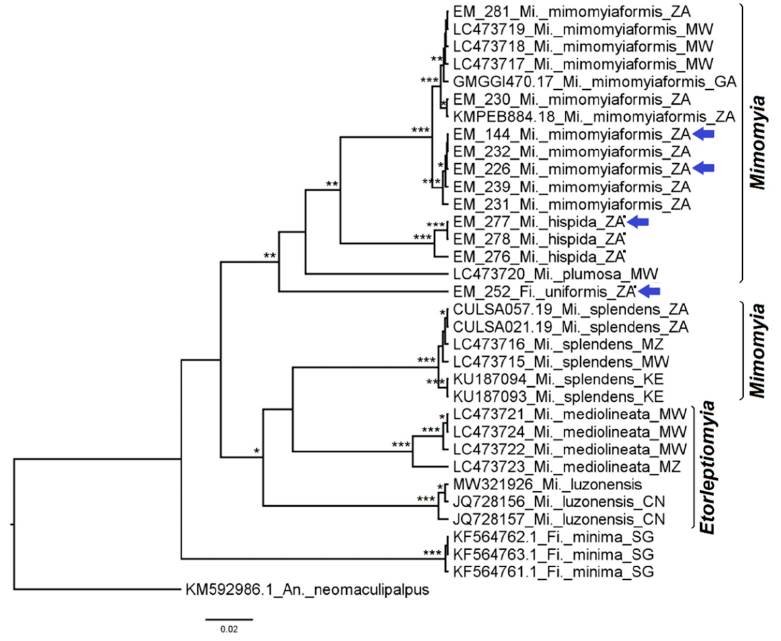
Figure 15 . Phylogenetic analysis of 33 partial coxI nucleotide sequences from mosquitoes of the Ficalbia and Mimomyia genera. At specific branches, the number of * indicates the tree topological support revealed by the different phylogenetic reconstruction methods, assuming relevant bootstrap and aLRT values above 75% and posterior probability values above 0.80. The sequences obtained in this work are indicated by the “EM” code and those with associated genitalia are indicated by horizontal blue arrows. The sequences downloaded from GenBank and Boldsystems are indicated by their respective accession numbers and access codes (respectively); the symbol “.” after the code of our sequence indicates that said sequence was not identified by Boldsystems. Their country of origin [South Africa (ZA), China (CN), Gabon (GA), Malawi (MW), Mozambique (MZ), Kenya (KE)] are also indicated. The vertical lines mark the subgenera of Mimomyia and Etorleptiomyia. 3.2.6. Genus Coquillettidia Sequences from the South African Cq. ( Coquillettidia ) chrysosoma (Edwards, 1915) specimens (File S-II Figure S51) grouped with Cq. ( Coq. ) fuscopennata (Theobald, 1903), Cq. ( Coq. ) aurites (Theobald, 1901), and Cq. chrysosoma sequences from Kenya, with an intra- clade variation of 0.2% ± 0.1 (Figure 16). Sequences of Cq. fuscopennata from South Africa (File S-II Figure S49) clustered with a sequence from Malawi in a monophyletic clade with an intraspecific variation of 0.5% ± 0.2, while another clade clustered GenBank sequences from Cq. fuscopennata , Cq. (Coq.) versicolor (Edwards, 1913) and Cq. (Coq.) microannulata (Theobald, 1911). The sequence of Cq . ( Coq. ) metallica (Theobald, 1901) from Mozambique (File S-II Figure S50) clustered in a monophyletic clade with an intraspecific variation of 1.1% ± 0.3. This was confirmed by network and PCOORD analyses (File S-IV, Figure S18).